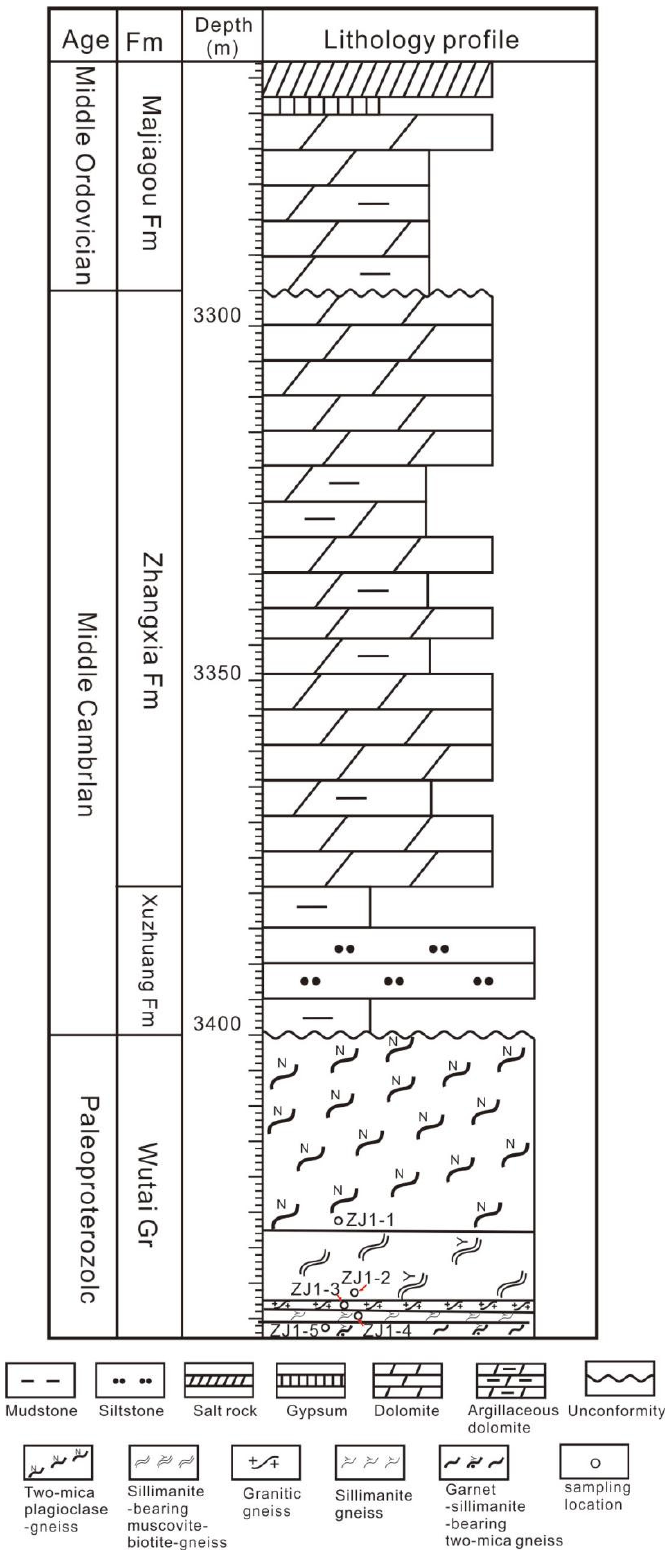
Figure 3. Columnar sections for drill hole ZJ-1 in the northeastern Ordos Basin. Sample locations are marked by open circular.